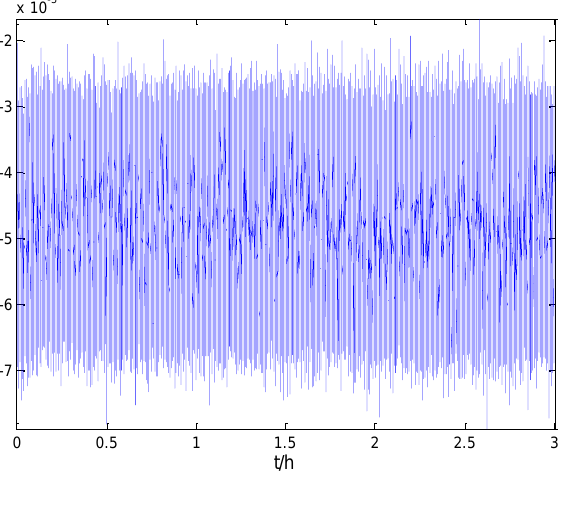
Figure 19. Raw data of #1 FOG.